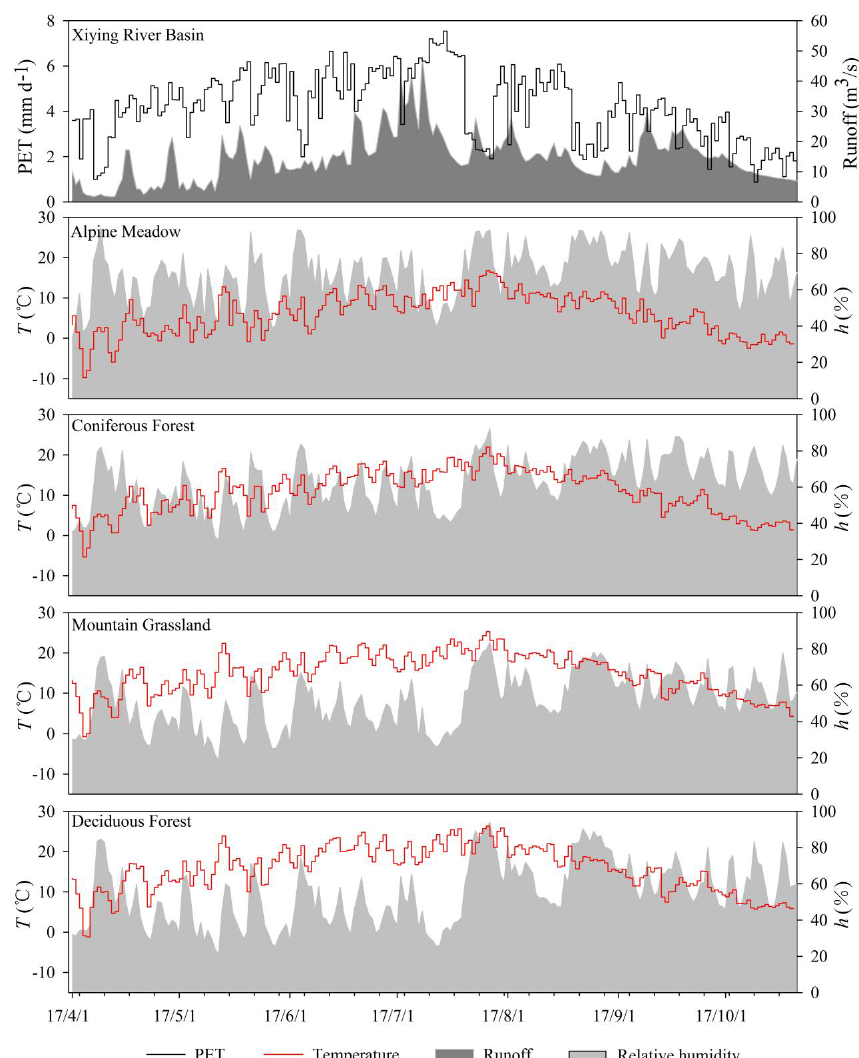
Figure 2. Climatic and hydrological conditions of the Xiying River